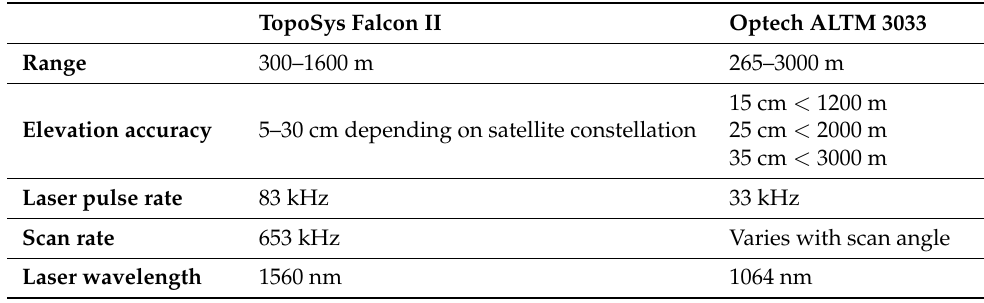
Table 1. Technical characteristics of the ALS